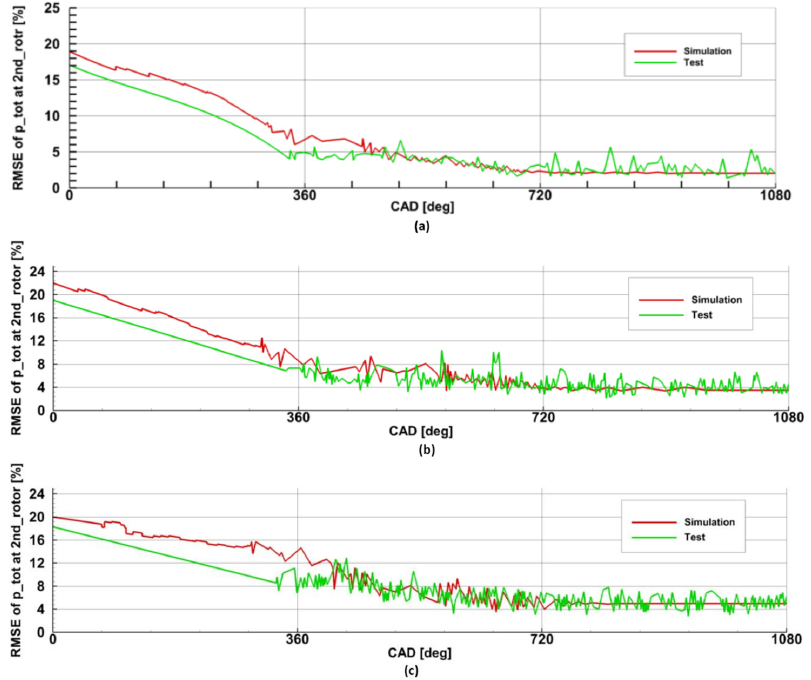
Figure 12. Validation of the numerical model for ( a ) 60,000 rpm, ( b ) 50,000 rpm, ( c ) 40,000 rpm. Figure 13 shows the residuals of the numerical simulation.